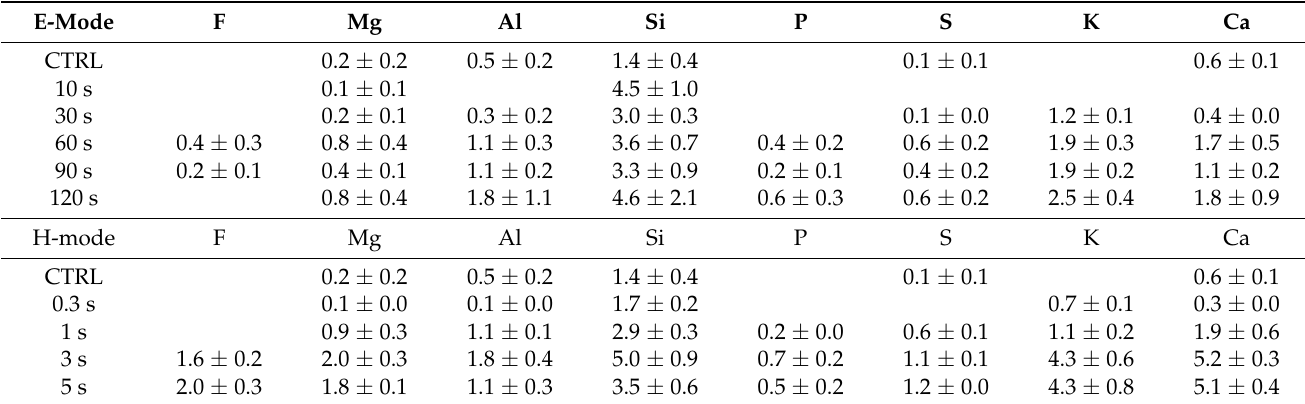
Table 2. Alfalfa seed surface concentration of minor elements, determined by X-Ray photoelectron spectroscopy (XPS) after treatment with E-mode or H-mode plasma. Expressed as at.%; standard error is